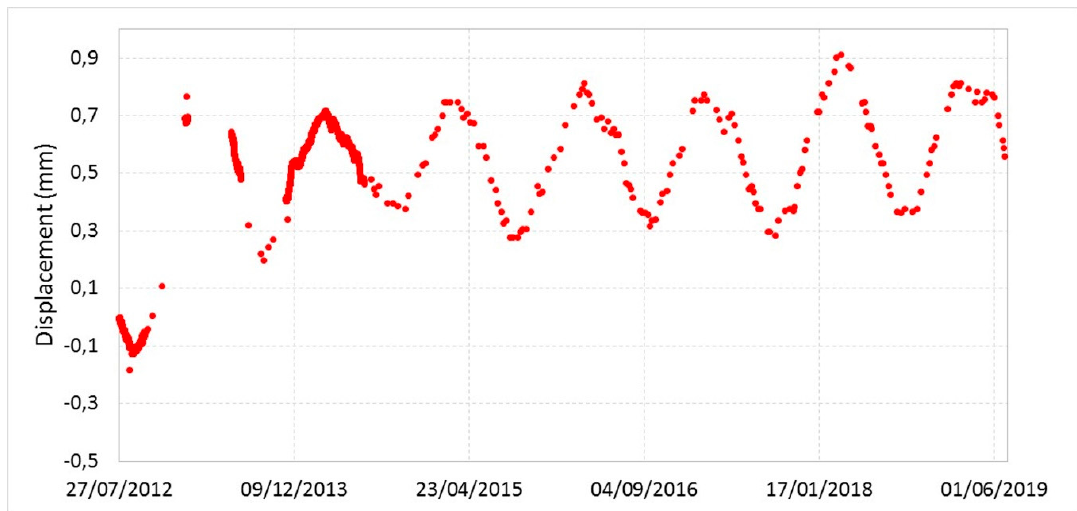
Figure 18 . Displacement recorded by the extensometer ES3B1, 6 m long sensor, from 2012 to 2019.